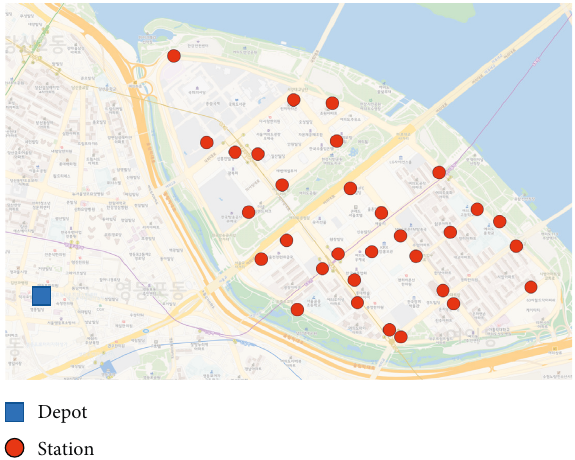
3: Daily pickup and return frequency by the time of